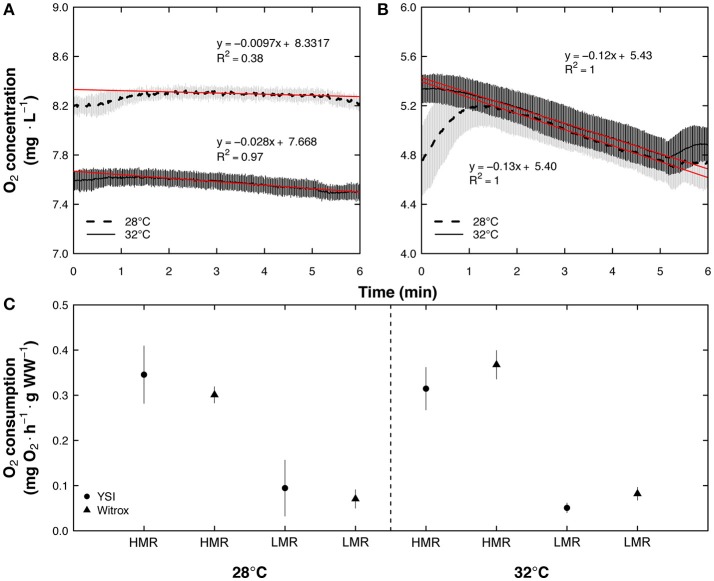
Temperature-induced metabolic rate (TIMR) measurements with PC-controlled fiber optic trace oxygen transmitter (Witrox) and a handheld dissolved oxygen meter (YSI) for Centropomus undecimalis acclimated at 28 and 32°C in a closed-system. (A) Measurements were made at low (110% CT min: TIMR min) and (B) high (90% CT max: TIMR max) temperatures for 23 C. undecimalis juveniles acclimated for 21 days at 28 (dashed line) and 32°C (full line). To calculate low metabolic rate (LMR at TIMR min) and high metabolic rate (HMR at TIMR max), the first and last minute of each slope was discarded due to the oxygen adjustments in the chamber when each fish was introduced and taken from the respirometric chamber, respectively. The background oxygen consumption obtained from control chambers without fish (n = 3 per TIMR and experimental temperature) was considered. HMR and LMR (mg O2 h−1 g−1 WW) measured with the optical sensor were calculated from the slopes of O2 consumed (red line). (C) These HMR and LMR (triangles; mean ± SD) were compared with those obtained from YSI instrument (circles; mean ± SD; mg O2 h−1 g−1 WW).